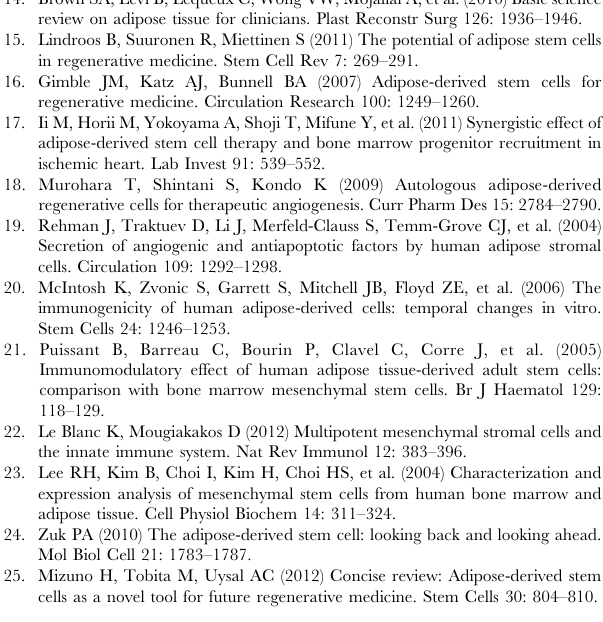
Figure S8 Expression of collagen III (Col III) in wounds. GFP-expressing ASCs were analyzed 7 days after transplantation in wounds. Chicken anti-GFP and mouse anti-Col III antibodies were used to detect GFP (green) and Col III (red). Nuclei were stained with DAPI. (A): Low magnification of wounds. (B-D): Higher magnifications of the indicated regions in A (white squares; labeled as i, ii, iii). (E–F): Higher magnifications of the indicated regions in C and D (white squares; labeled as iv and v). Merged images of Col III and GFP were shown. Scale bars: 500 m m (A), 100 m m (B, C, D), 50 m m (E, F). (PDF) Figure S9 Analysis of expression of CD31 (PECAM-1) in transplanted ASCs. GFP-expressing ASCs were analyzed 7 days after transplantation in wounds. Chicken anti-GFP (A, D) and mouse anti-CD31 (B, E) antibodies were used to detect GFP and CD31. Nuclei were stained with DAPI. Co-expression of CD31 and GFP was not detected in the merged images (C, F). Two examples, section 1 and section 2, from the same wound were shown. Scale bar; 50 m m. (PDF) Figure S10 Transplanted ASCs proliferate in wounds. GFP-expressing ASCs were analyzed 7 days after transplantation in wounds. Chicken anti-GFP (A) and mouse anti-PCNA (C) antibodies were used. Nuclei were stained with DAPI (B). Merged image was shown in D. Scale bars: 50 m m.